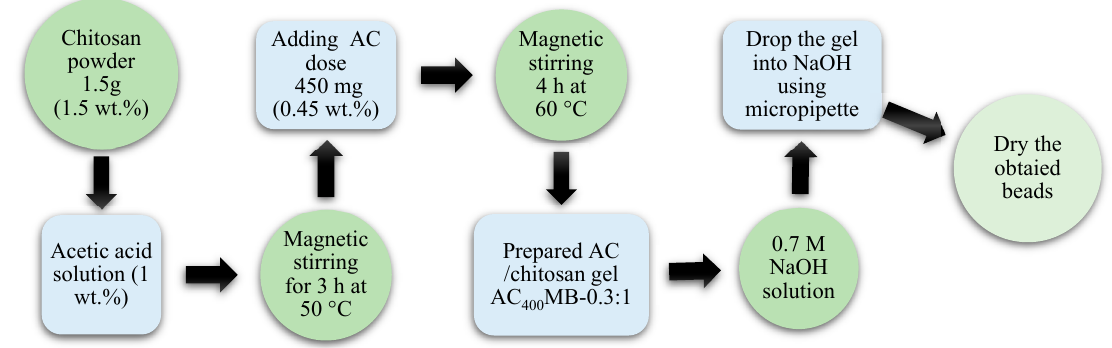
Figure 2. The preparation process for activated carbon/chitosan beads (AC 400°C MB-0.3:1).